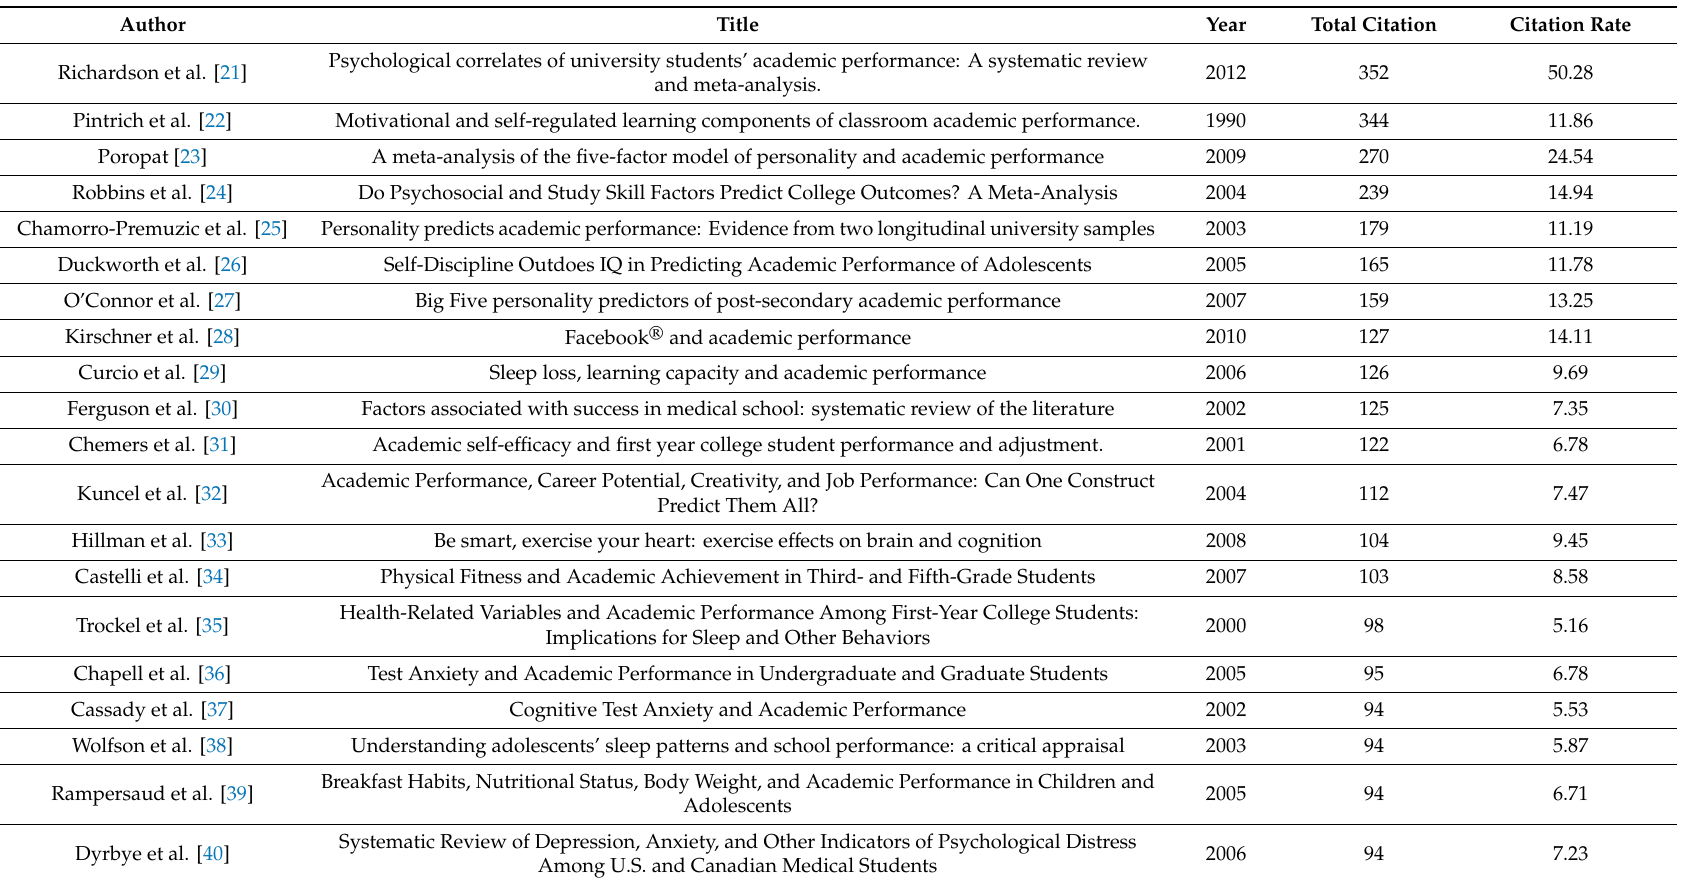
Table 1. Details of the 20 most cited publications on academic